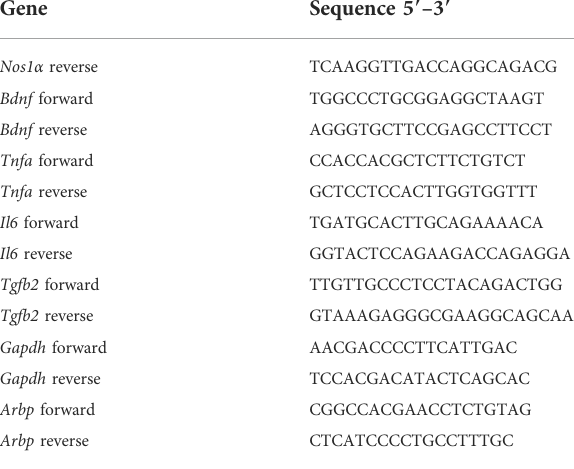
TABLE 1 Primers used for gene expression